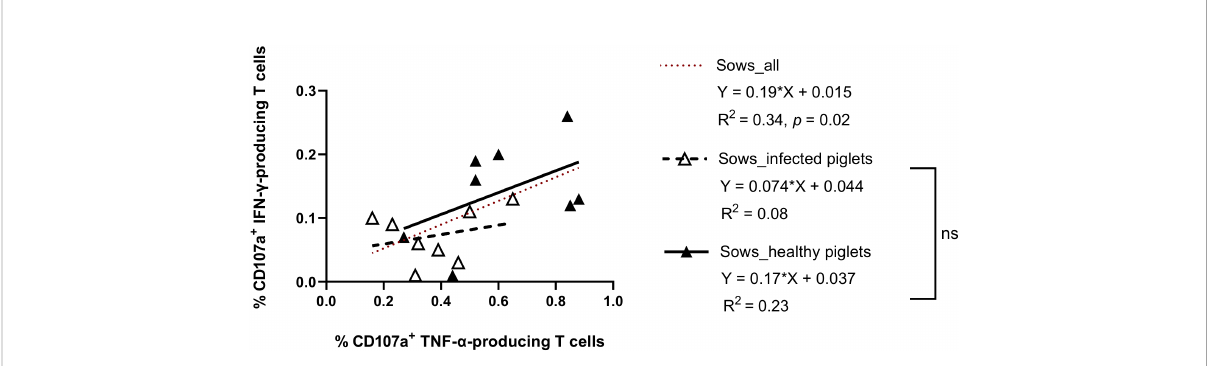
FIGURE 4 Scatter plots showing the relationship between CD107a + IFN- g - and CD107a + TNF- a -producing T cells in sows delivering PRRSV-1 JA2- infected and healthy piglets. Dashed line (in red), linear regression line of the relationship between CD107a + IFN- g -producing T cells and CD107a + TNF- a -producing T cells considering all animals., Empty triangle, sows delivering infected piglets; solid triangle, sows delivering healthy piglets. Dashed line (in black), linear regression of sows delivering JA2-infected piglets; solid line (in black), linear regression of sows delivering healthy piglets. Slopes for the regression lines of healthy and infected animals were not signi fi cantly different, ns: not signi fi cant.